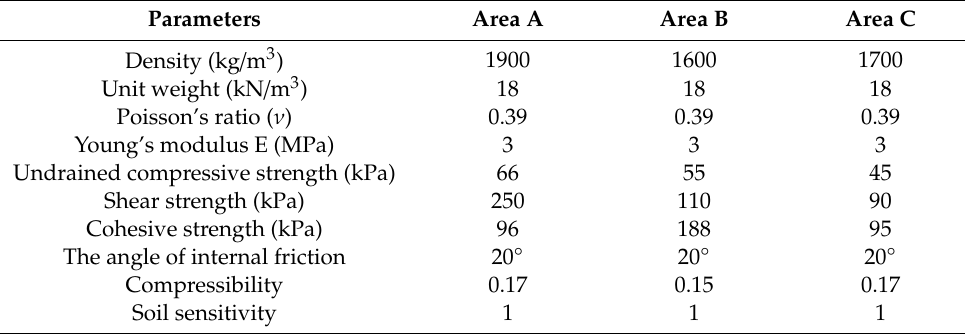
Table 3. Mechanical properties of soils in areas A, B, and C.